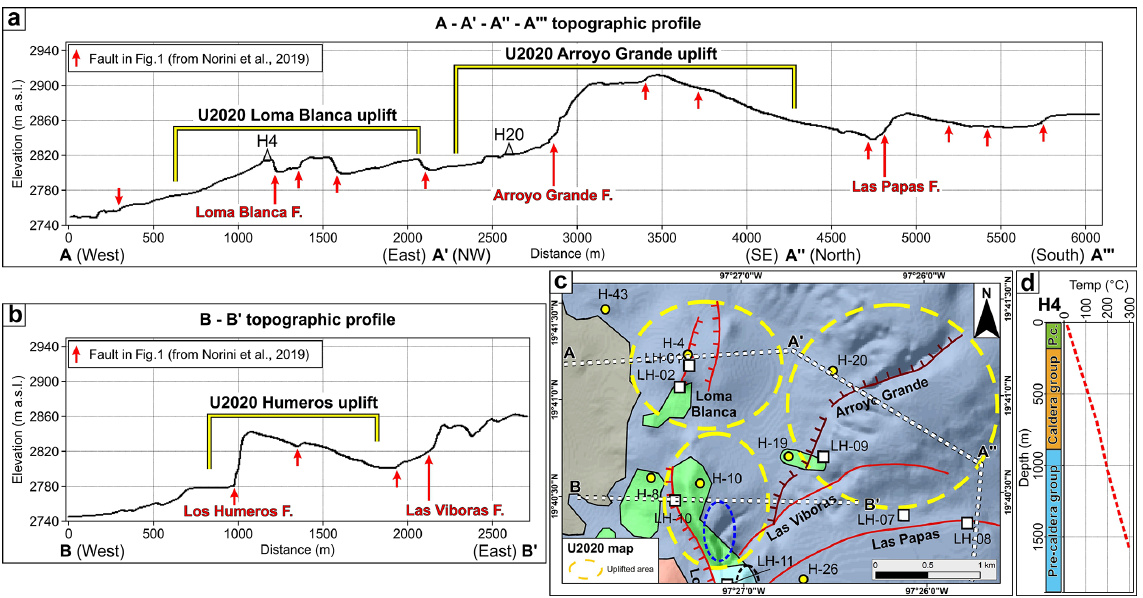
Figure 4. Topographic profiles along the (a) A–A (cid:48) –A (cid:48)(cid:48) –A (cid:48)(cid:48)(cid:48) and (b) B–B (cid:48) traces shown in Fig. 1 and (c) schematic geological map (modified from U2020) outlining the three uplifted areas discussed by U2020; the traces of the two topographic profiles and the locations of the H4 and H20 wells are also shown. (d) H4 lithological and temperature log (well data from Arellano et al., 2003, and U2020). P.c.: post-caldera